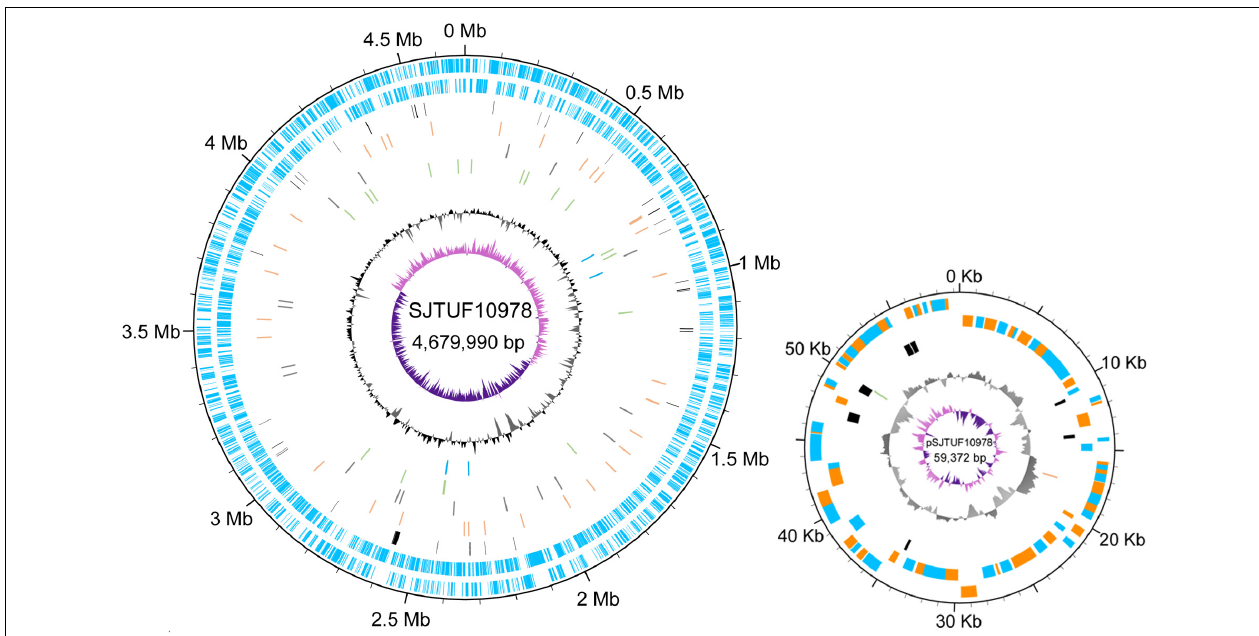
FIGURE 2 | Circular map and genetic features of Salmonella Enteritidis strain SJTUF10978 relative to strain SJTUF10984. For the figure of the chromosome, light blue bars (first and second rings) indicate the coding sequences on the positive and negative strands, respectively. Orange, gray, green, and blue bars (fourth, fifth, sixth, and seventh rings) denote the non-synonymous SNPs, synonymous SNPs, intergenic SNPs, and INDELs between SJTUF10978 and SJTUF10984, respectively. For the figure of the plasmid of SJTUF10978, arcs in the first and second rings represent coding sequences on the positive and negative strands, respectively, and blue and orange were used to distinguish neighboring genes. The orange and green bars in the fourth ring indicate a non-synonymous SNP and an INDEL between plasmids of SJTUF10978 and SJTUF10984. For both figures, black bars (third ring) indicate pseudogenes and the black/gray and dark purple/light purple plots display GC content and GC skew ([G+C]/[G–C]), respectively (window size 10,000 bp and step size 200 bp for the chromosome, window size 500 bp, and step size 20 bp for the plasmid). The atlas was created using the Plotrix package (version 3.6-6; Lemon, 2006) within R (version 3.2.5; R Development Core Team,